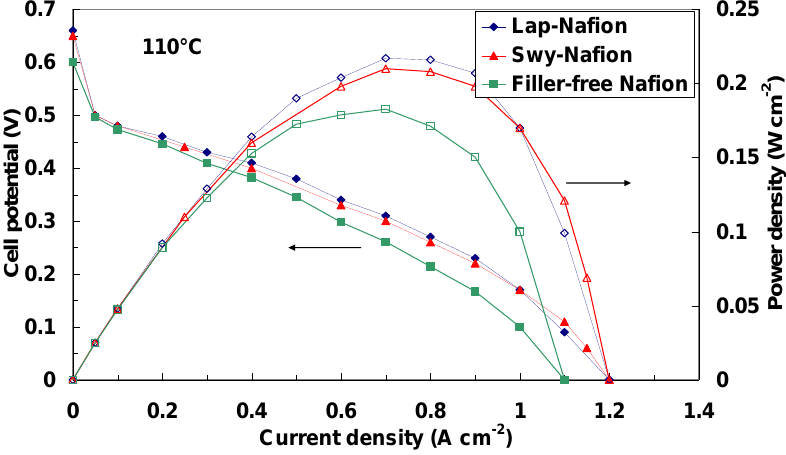
Figure 10. DMFC polarization and power density curves at 110 °C for various membrane-electrode assemblies equipped with composite and filler-free